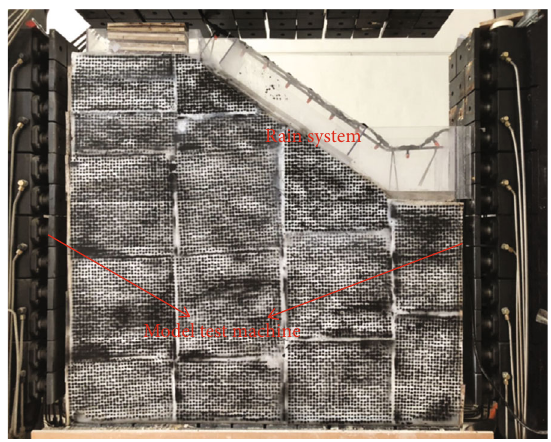
Figure 20: Model experiment